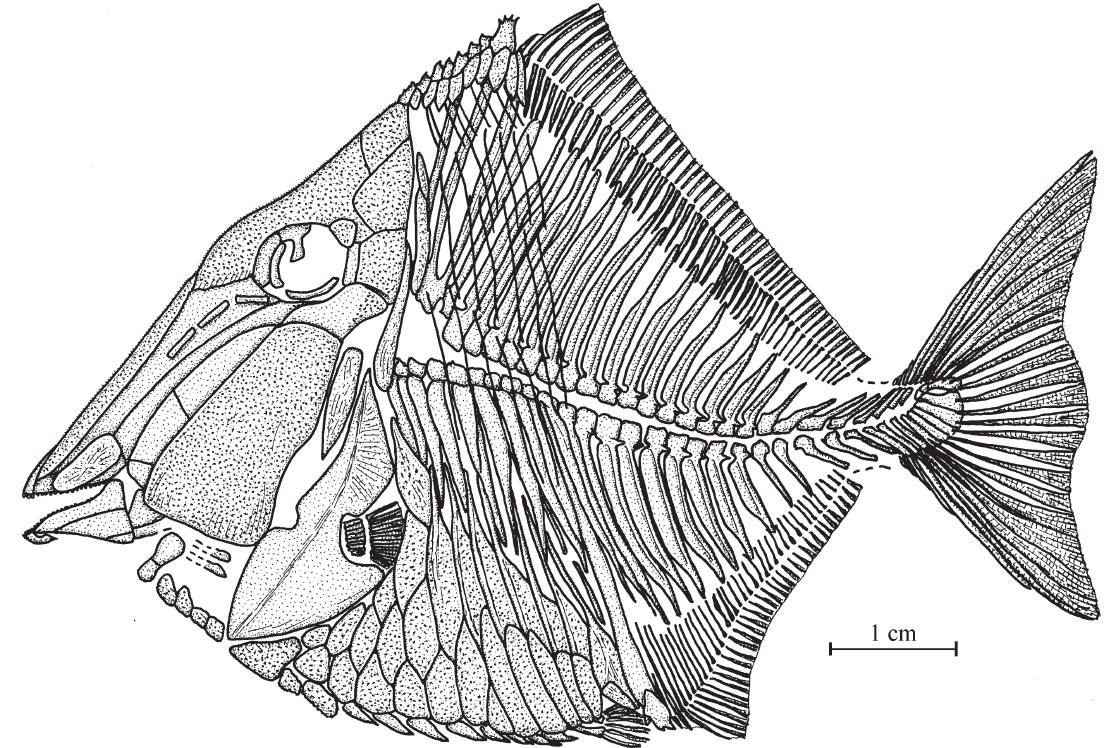
Fig. 5. Acrorhinichthys poyatoi gen. et sp. nov. Reconstruction based on the three specimens. The scale refers to the holotype CLC